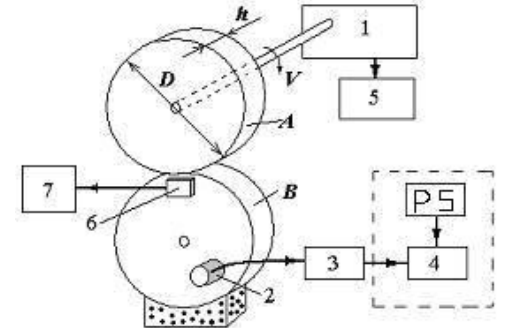
Fig 3. AE signal research method for the friction pair is the ki- nematic scheme “roller-roller” (“disk-disk”): A is a movable sample; B is stationary sample; D and h are sample diameter and thickness; V is movable sample rotation speed; 1 is the CMT-1 universal friction device; 2 is the AE signal transducer; 3 is the preliminary amplifier; 4 is the mobile computer; 5 is the friction moment gauge and PS is the program software